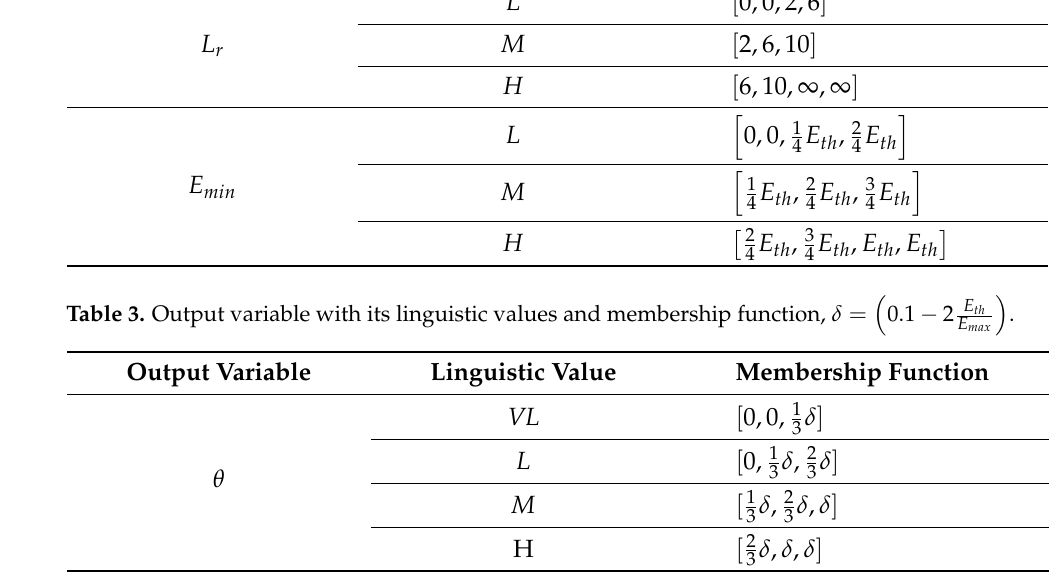
Table 2. Input variables with their linguistic values and corresponding membership function.